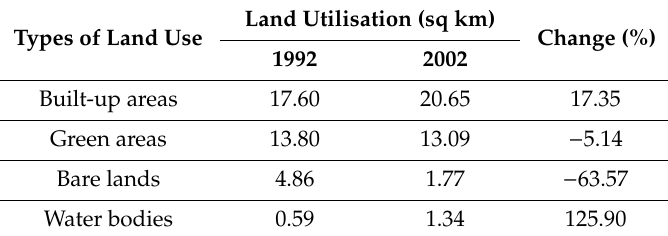
Table 2. Changes in land utilisation in Nakhon Ratchasima between 1992 and 2002.